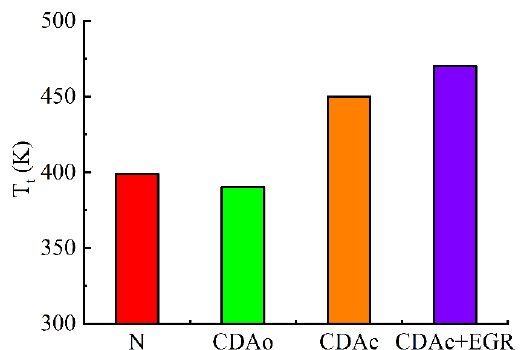
Figure 18. The exhaust gas temperature for the normal operation and CDA modes at an engine speed of 450 rpm and engine loads of 1000 N ∙ m and 4000 N ∙ m (the calculated results were obtained from 1D simulation of GT-SUITE).